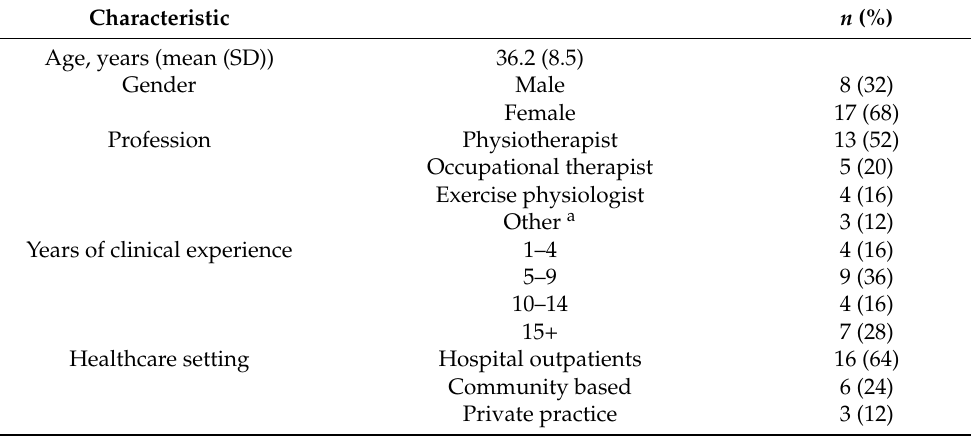
Table 2. Demographic profile of participants ( n =